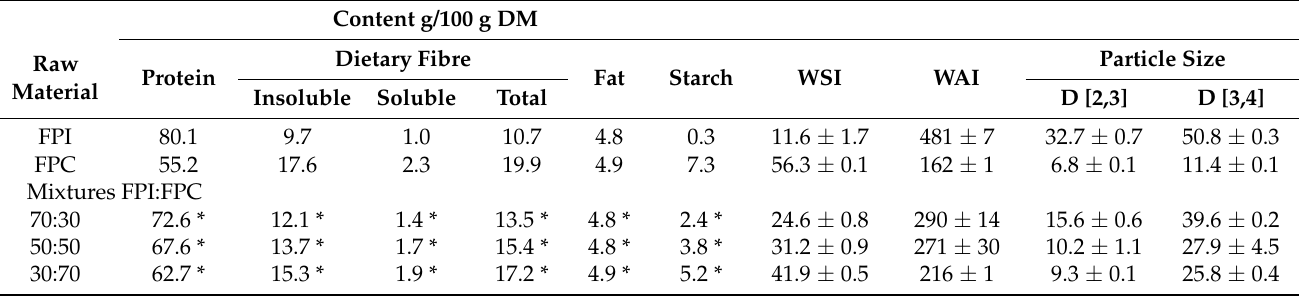
Table 1. Chemical, physicochemical, and physical properties of the raw materials, including faba bean protein isolate (FPI) and faba bean protein concentrate (FPC) and their mixtures.